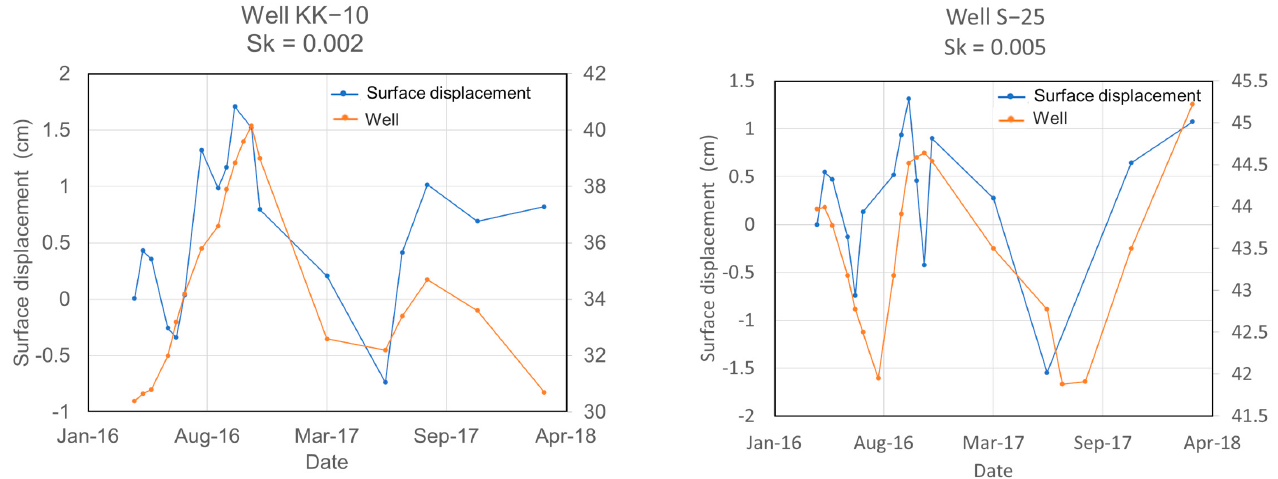
Figure 5. Time series of InSAR deformation and groundwater-level data at two well sites (KK − 10 and S − 25) after excluding outliers. Red triangles in Figures 1 and 3b are the locations of both wells.